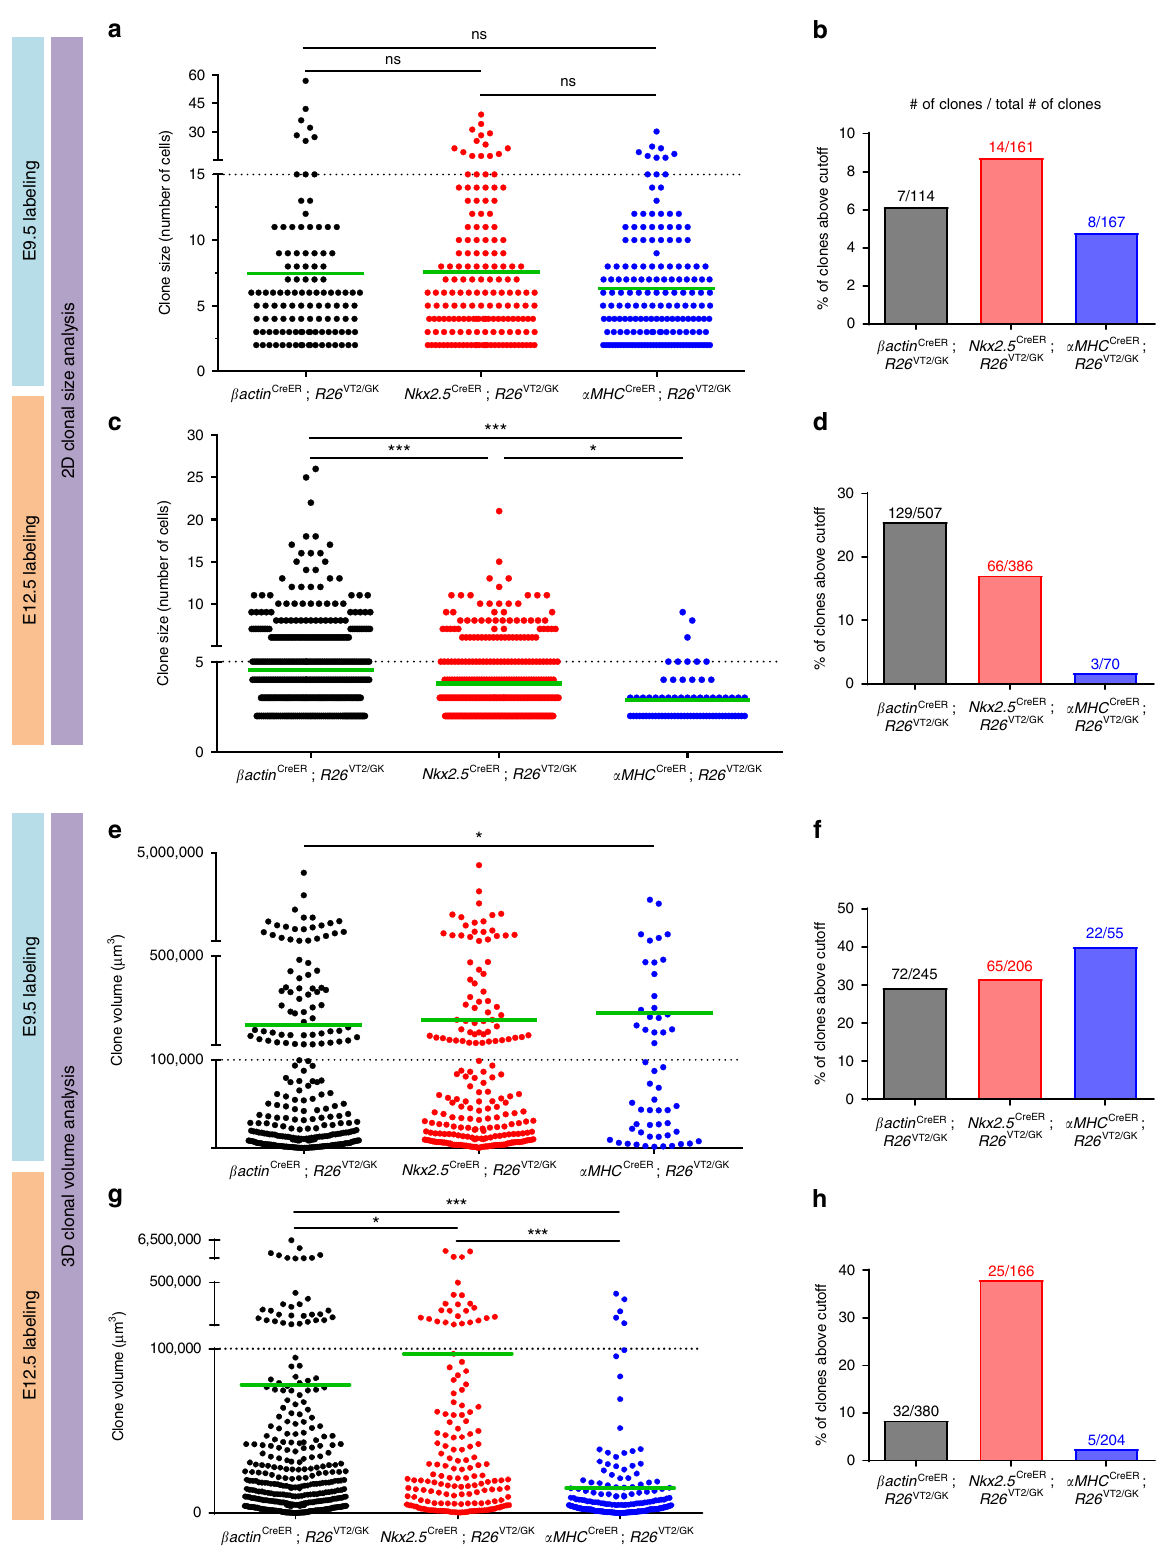
Fig. 3 2D and 3D quanti fi cation reveals a dramatic decrease in the proliferative capacity of α MHC-expressing cells. Quanti fi cation of clonal expansion in P2 β actin CreER ; R26 VT2/GK , Nkx2.5 CreER ; R26 VT2/GK , and α MHC CreER ; R26 VT2/GK hearts labeled at E9.5 ( a , b , e , f ) and E12.5 ( c , d , g , h ) (two-sample Kolmogorov – Smirnov distribution test) * p < 0.05, ** p < 0.01, *** p < 0.001. Two dimensional quanti fi cation of clonal expansion ( a , c ) and bar graphs highlighting the scarcity of large clones in α MHC CreER ; R26 VT2/GK hearts ( b , d ), respectively. Three-dimensional quanti fi cation of clone volumes in P2 hearts ( e , g ) and bar graphs depicting clones volumes in α MHC CreER ; R26 VT2/GK hearts ( f , h ). Green lines depict mean values. Dashed lines depict